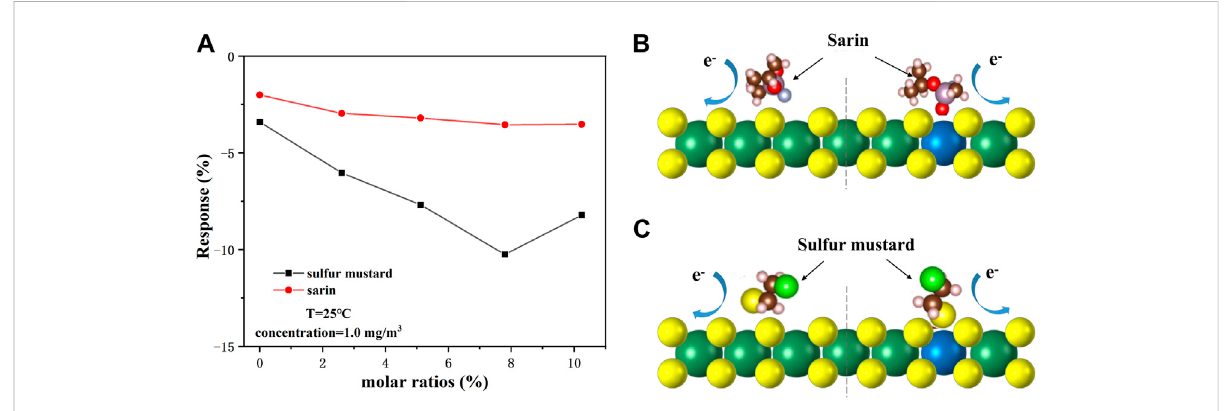
FIGURE 8 (A) Responses of different molar ratios of Nb-MoS 2 NSs-based gas sensors to 1.0 mg/m 3 sarin and sulfur mustard. Schematic diagram of the adsorption model of (B) sarin on MoS 2 NSs before doping with Nb (left) and after (right), and (C) sulfur mustard on MoS 2 NSs before doping with Nb (left) and after